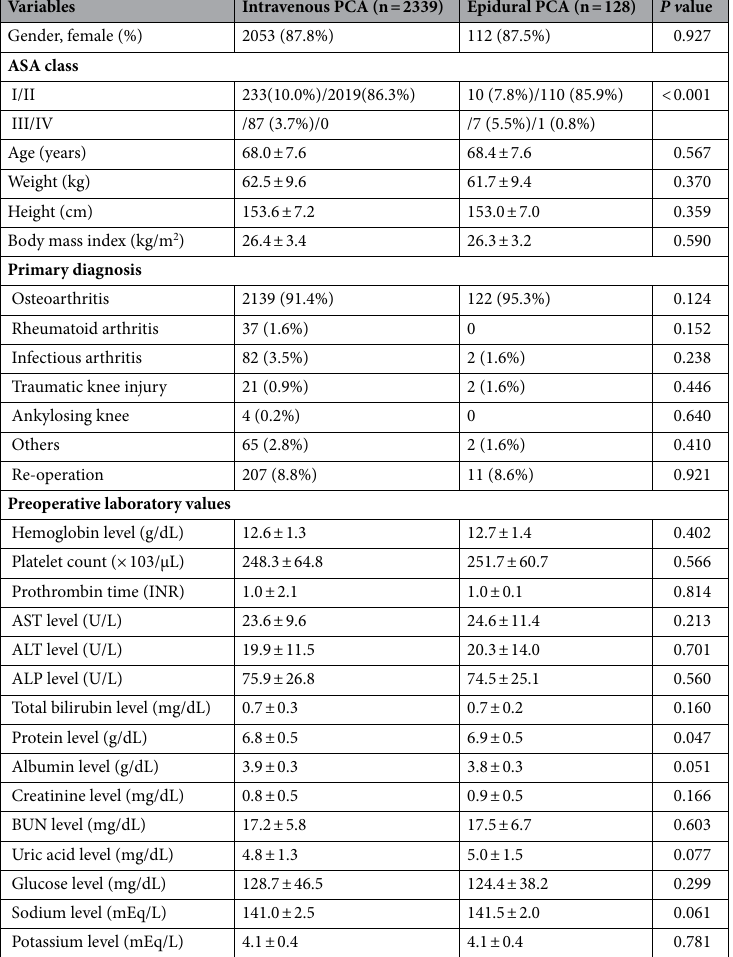
Table 1. Unmatched preoperative characteristics and preoperative laboratory values between the intravenous PCA and epidural PCA groups. Data are presented as mean ± standard deviation or number (%), as appropriate. PCA patient-controlled analgesia, ASA American Society of Anesthesiologists, INR international normalized ratio, AST aspartate transaminase, ALT alanine transaminase, ALP alkaline phosphatase, BUN blood urea nitrogen. Others include avascular necrosis, desmoplastic fibroma, fibrous dysplasia, pigmented villonodular synovitis, spontaneous osteonecrosis, valgus knee, spastic diplegia of cerebral palsy, and fused knee.